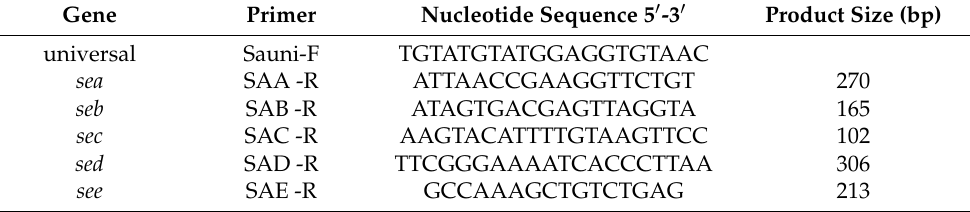
Table 1. Primers used in multiplex PCR to detect staphylococcal enterotoxins